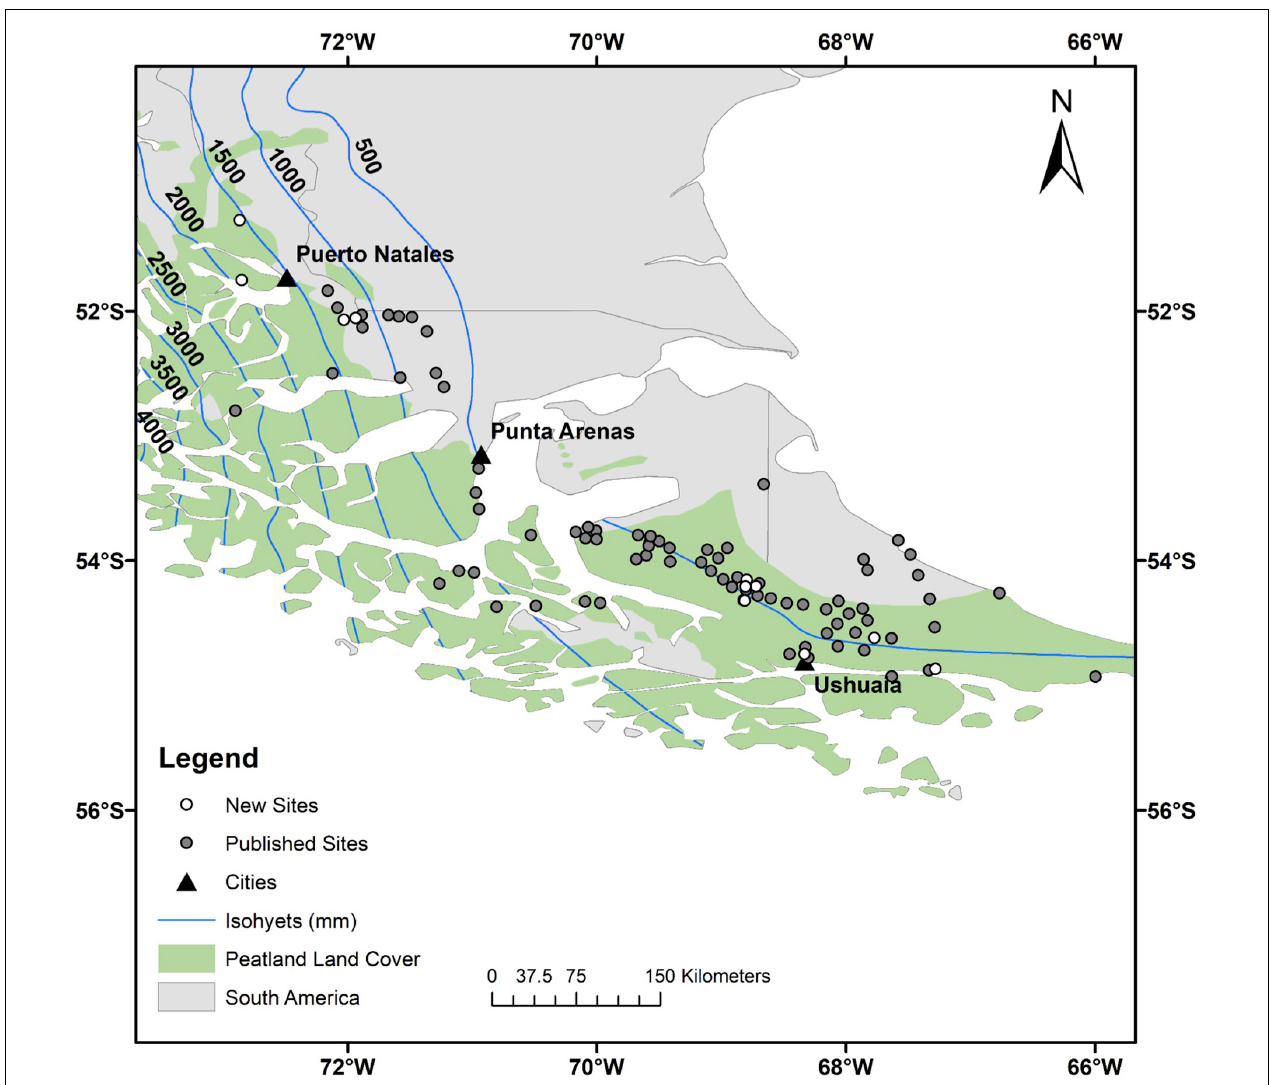
FIGURE 1 | Study region, southern South America. The open circles indicate our 12 new cores, the gray circles show the location of the 78 sites from the literature review, and the black triangles locate the main towns. The peatland area is from Yu et al. (2010) and the dataset used to generate the isohyets is from New et al. (2002). Detailed maps with site names can be found in the Supplementary Information ( Supplementary Figure S1